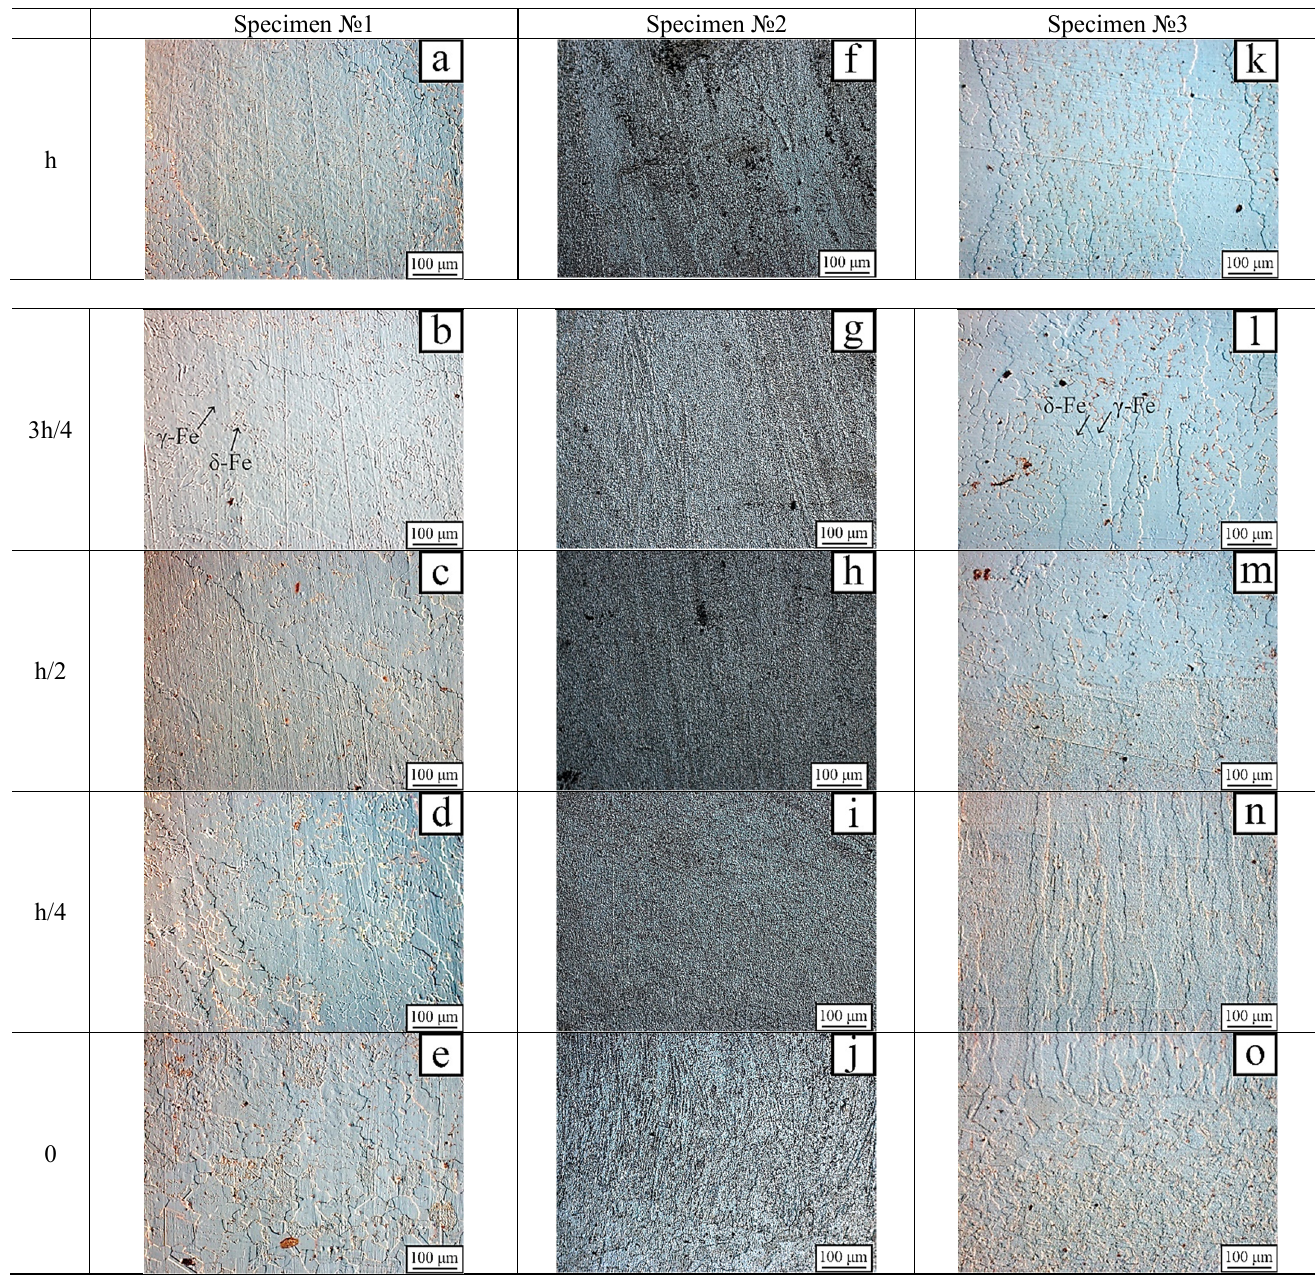
7 of 14 Figure 6. Images of specimens from cross-sections of investigated workpieces: ( а ) specimen № 1; ( b ) specimen № 2, ( c ) specimen № 3. From Figure 6, it can be observed that the use of shaping blocks (Figure 6a,b) makes it possible to obtain a final product with a flatter outside surface. The other side’s uneven- ness projections are visible in case the specimen is obtained without the use of blocks (Fig- ure 6c). The above makes it possible to further reduce the cost of mechanical post-pro- cessing by using the shaping blocks. In addition, the presence of symmetry should lead to a smaller difference between the property values in different parts of the build-up work- pieces. For further investigation, dimensionless values for the height and width of the spec- imens were introduced due to the difference in sizes of workpieces (Figure 6). Specimen height (H) changes from 0 to h. The value of H = 0 corresponds to the transition area be- tween the steel substrate and the first layer of the specimen. The width of the specimen (L) changes from 0 to l, where L = 0 corresponds to the left edge of the specimen, and L = l to the right edge. The geometric parameters of the specimens were divided into equal